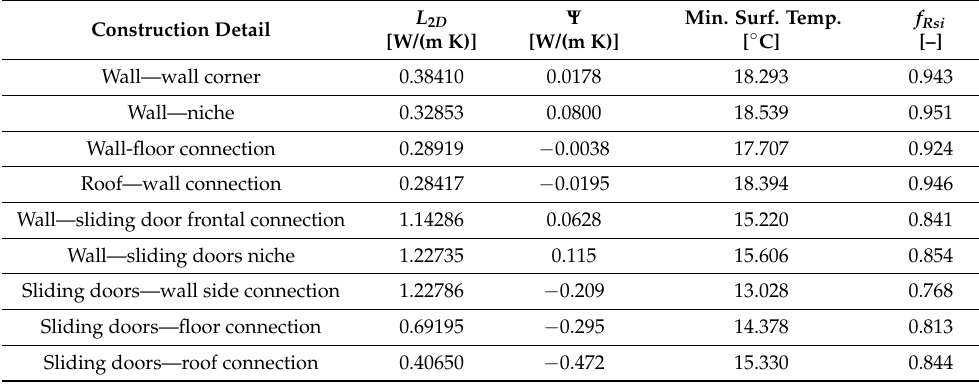
Figure 10. Geometrical models and temperature distribution of the analysed thermal bridges. Table 6. Results of numerical analysis of the analysed thermal bridges.